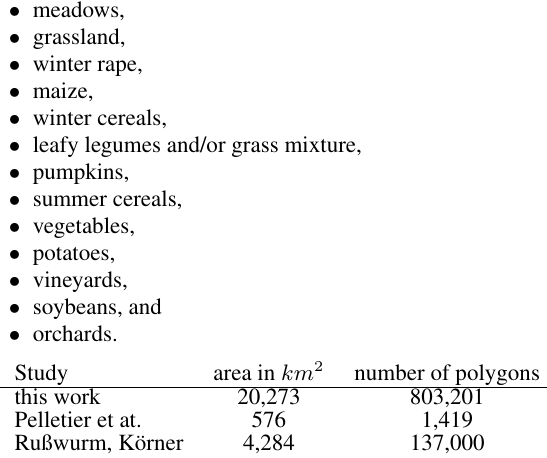
Table 1. Overview of amount of data in (Pelletier et al., 2019) and (Rußwurm, K¨orner, 2018)